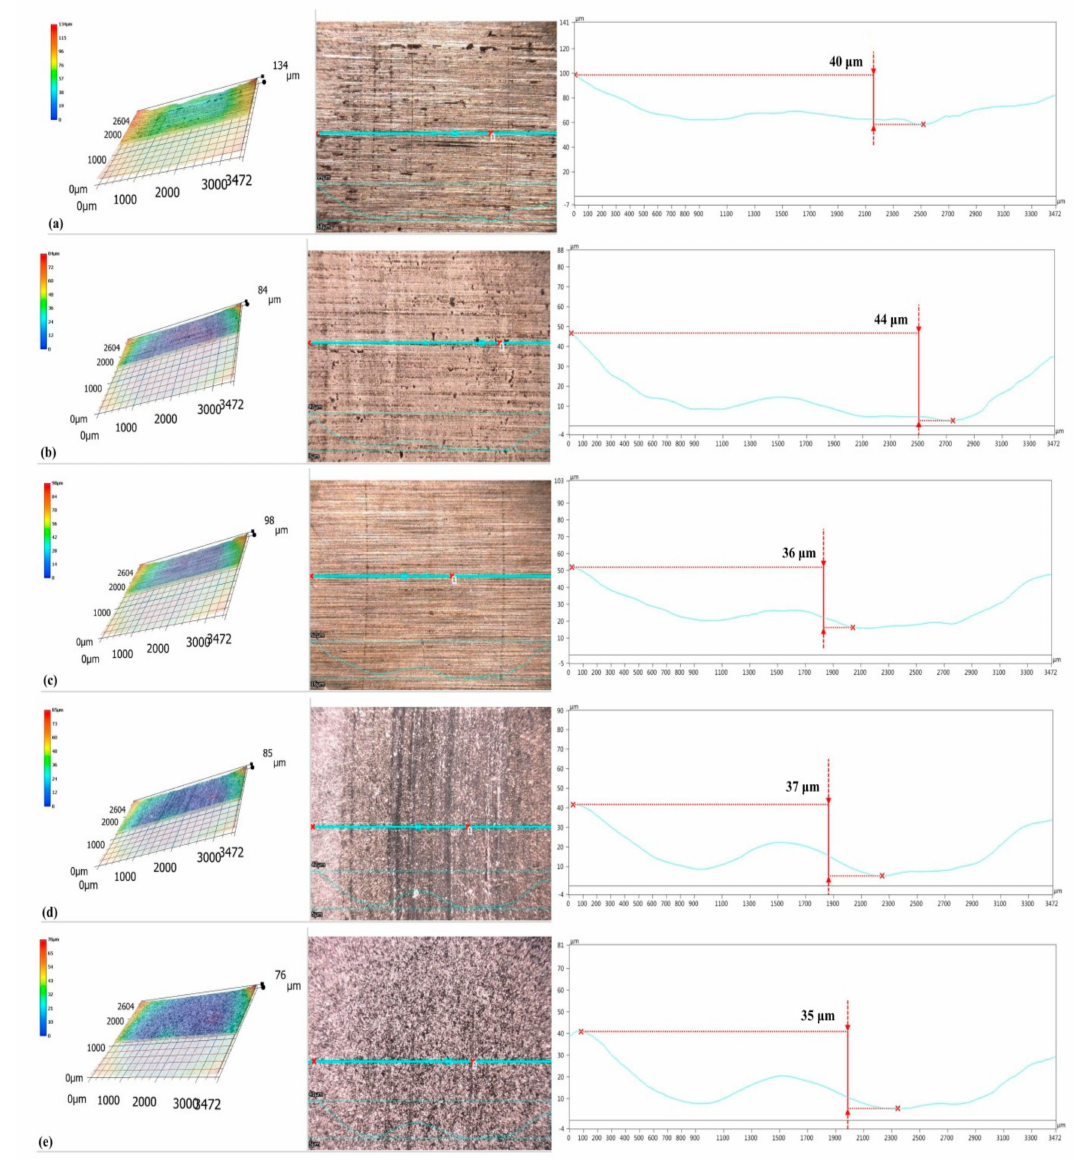
Figure 7. Worn surface scars of the lower specimens (100 N, 300 r / min): ( a ) 17-4PH; ( b ) Cr 3 C 2 -NiCr; ( c )